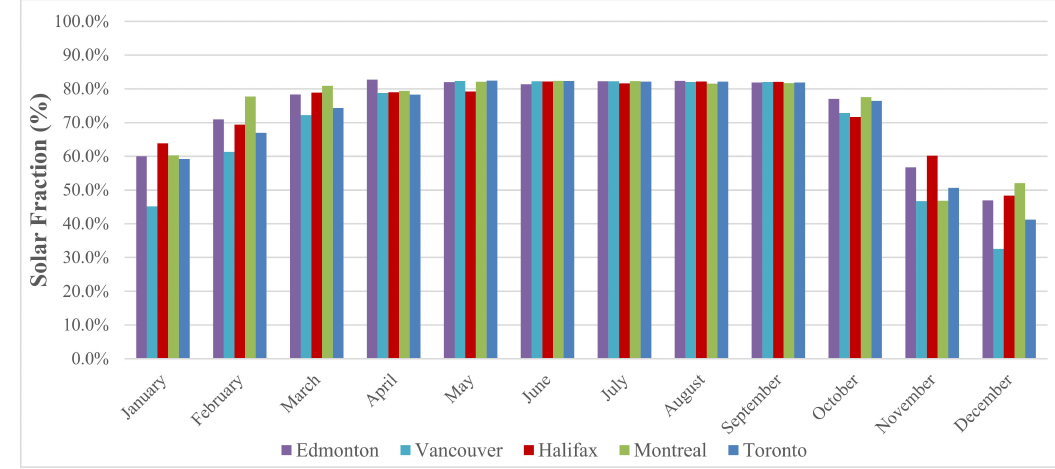
Figure 19. Monthly SF of MCST-HP system in different